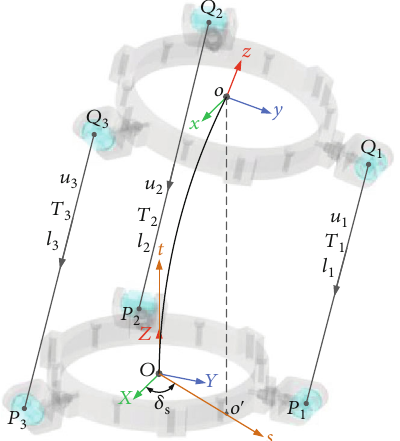
Figure 9: Schematic diagram of the bionic fl exible rope-driven parallel